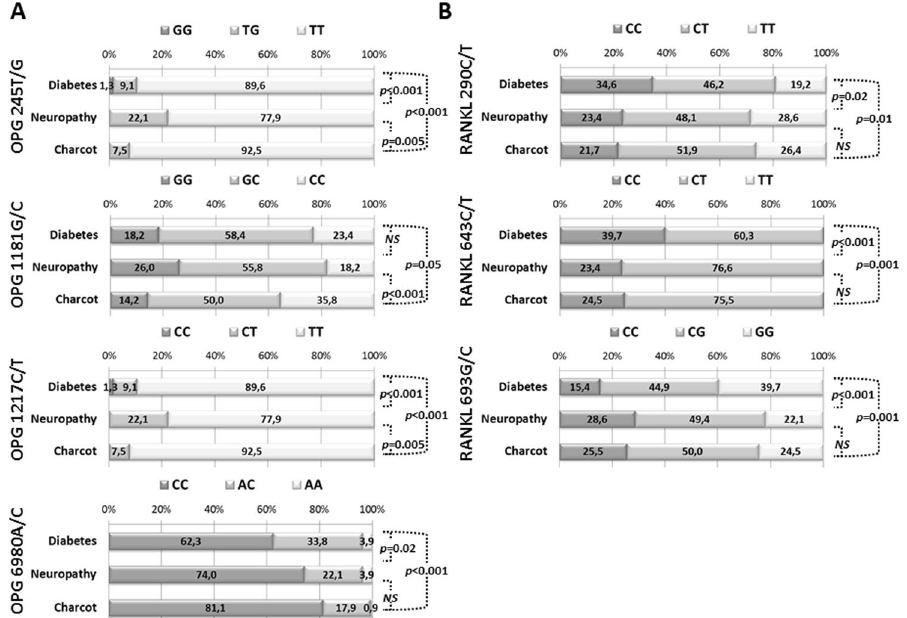
Figure 1. Distribution of genotypes at selected polymorphic loci , in the studied groups of patients. Stacked bar charts present percentage of each genotype at a given loci in patients with diabetes, neuropathy and Charcot arthropathy. Polymorphisms in the OPG gene are listed in panel A and polymorphisms in RANKL are listed in panel B. The calculated differences have been tested with the chi square test and p values for a given comparison are presented on the right side of each graph; NS stands for not significant. Only loci with significant difference in distribution are